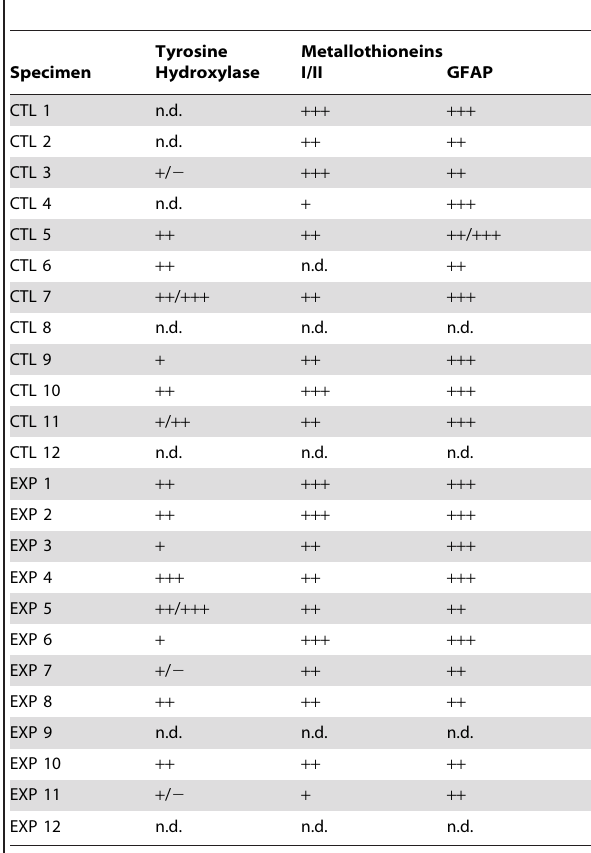
Table 1. Immunohistochemistry – Average of three independent